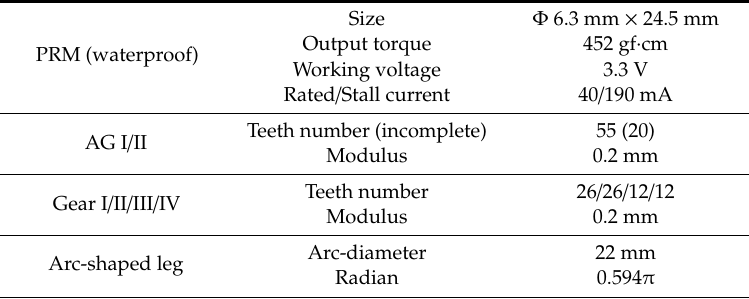
Figure 2. ( a ) Overall design of the expanding mechanism (EM); ( b ) working principle of the EM; ( c ) installation of the contact device; ( d ) cutaway view of EM, which shows the installations of AG I and AG II; ( e ) fabricated prototype of the EM. Table 3. Design parameters of the expanding mechanism (EM).